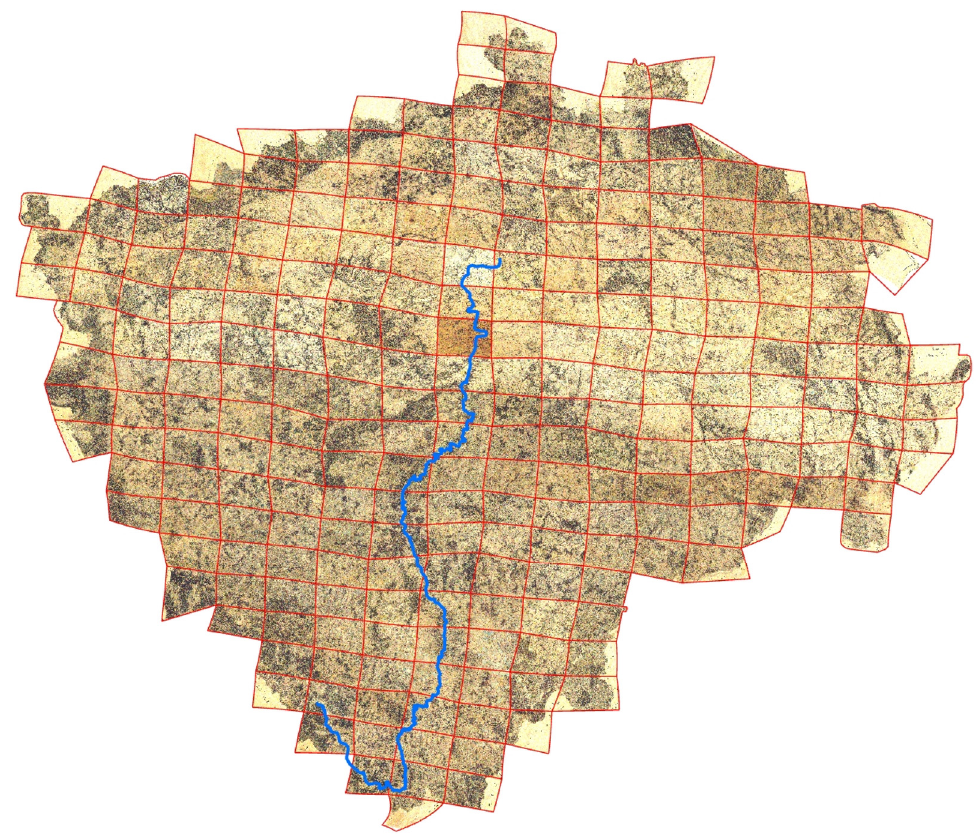
Figure 4. Complete mosaic of the First Military Survey, Source: author’s elaboration.